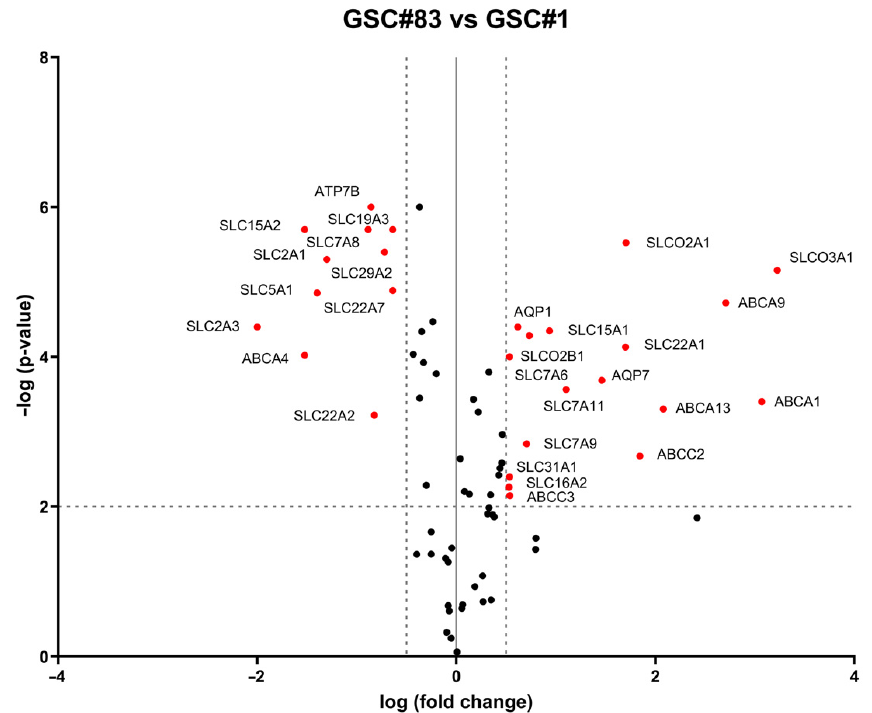
Figure 5. Differential expression analysis between GSC#83 and GSC#1 cell lines. Volcano plot illustrates the relative expression levels for each gene depicted as log 10 (n-fold) plotted against –log 10 ( p -value) between GSC#83 and GSC#1. Horizontal bar at y = 2 represents a significance level of p =0.01; vertical bars at x = ± 0.5 represent the fold change threshold (genes in black did not reach significance). The red plus signs represent upregulated or downregulated differentially expressed genes; the black circles represent non-differentially expressed genes. Genes not expressed in both cell lines were excluded from the graph. ATP-binding cassette, sub-family A (ABC1), member 1